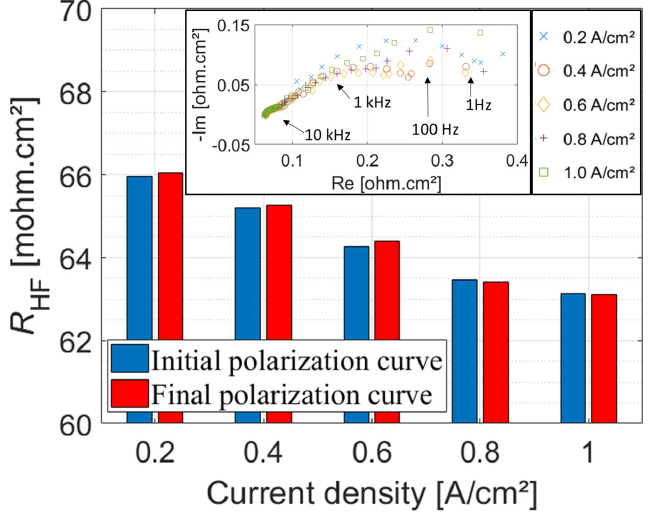
Figure 6. High-frequency resistances R HF measured by EIS performed on the polarization curves before (initial) and after (final) the design of experiments in pressure and temperature represented in histograms as a function of the current density.